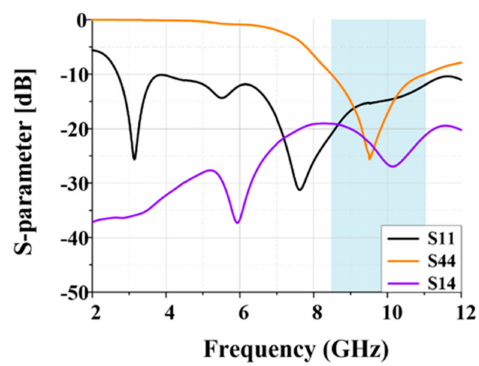
Figure 10. Simulated S-parameters of the proposed antenna for communication mode